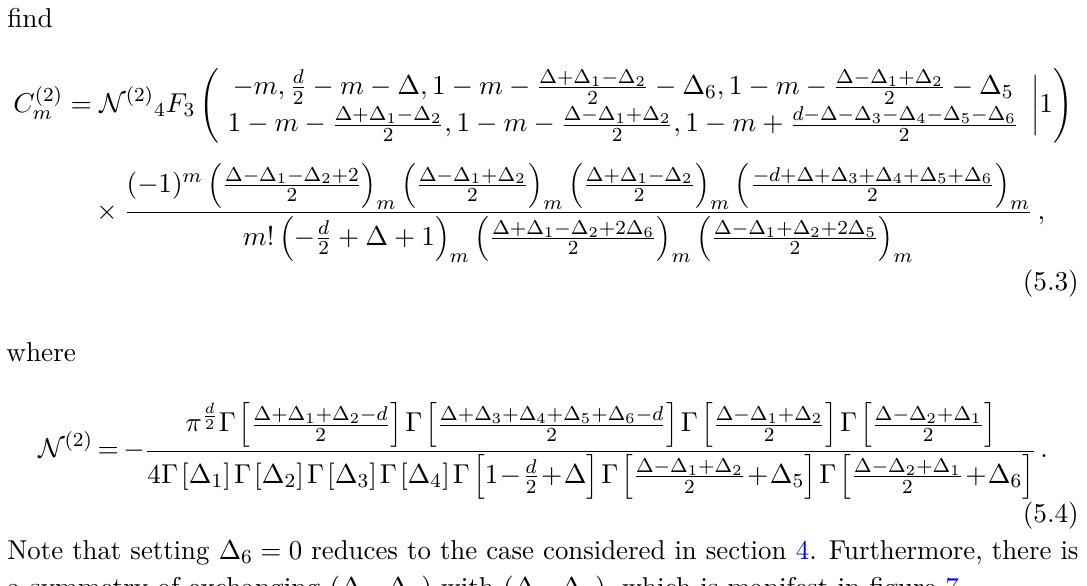
Figure 8 . The exchange Witten diagram figure 7 with two bound states can be obtained from a six-point exchange Witten diagram (denoted by W I where x , x 6 → x 1 5 → x 2